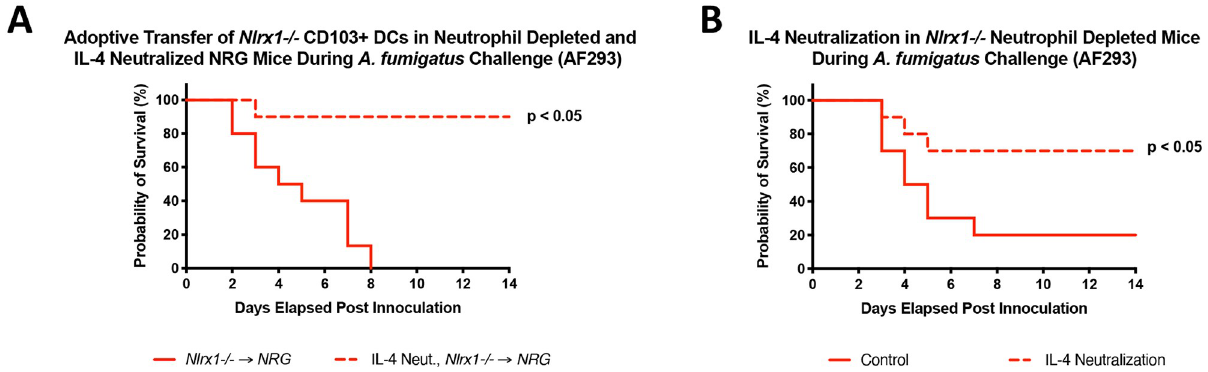
Fig 7. The effect of global IL-4 neutralization on survival during neutropenia models of invasive pulmonary aspergillosis using NRG and Nlrx1-/- mice. (A) Survival study post adoptive transfer of Nlrx1-/- CD103+ dendritic cells into NRG mice depleted of neutrophils via Ly6G+ depletion (1A8 Clone) and IL-4 neutralization (IL-4 Neut., Nlrx1-/- ! NRG) or isotype control ( Nlrx1-/- ! NRG) antibody one day prior and three days post inoculation with AF293 conidia via non-invasive intratracheal instillation (10 7 conidia/ 25 μ L). (B) Survival study for Nlrx1-/- mice depleted of neutrophils via Ly6G+ depletion (1A8 Clone) and IL-4 neutralization ((IL-4 Neut.) or isotype control antibody (Control) one day prior and three days post inoculation with AF293 conidia via non-invasive intratracheal instillation (10 7 conidia/ 25 μ L). Statistical significance was determined using the log-rank (Mantel-Cox) test. N = 10 per experimental